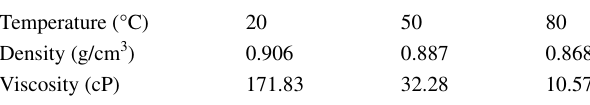
Table 1 Measured oil properties at different